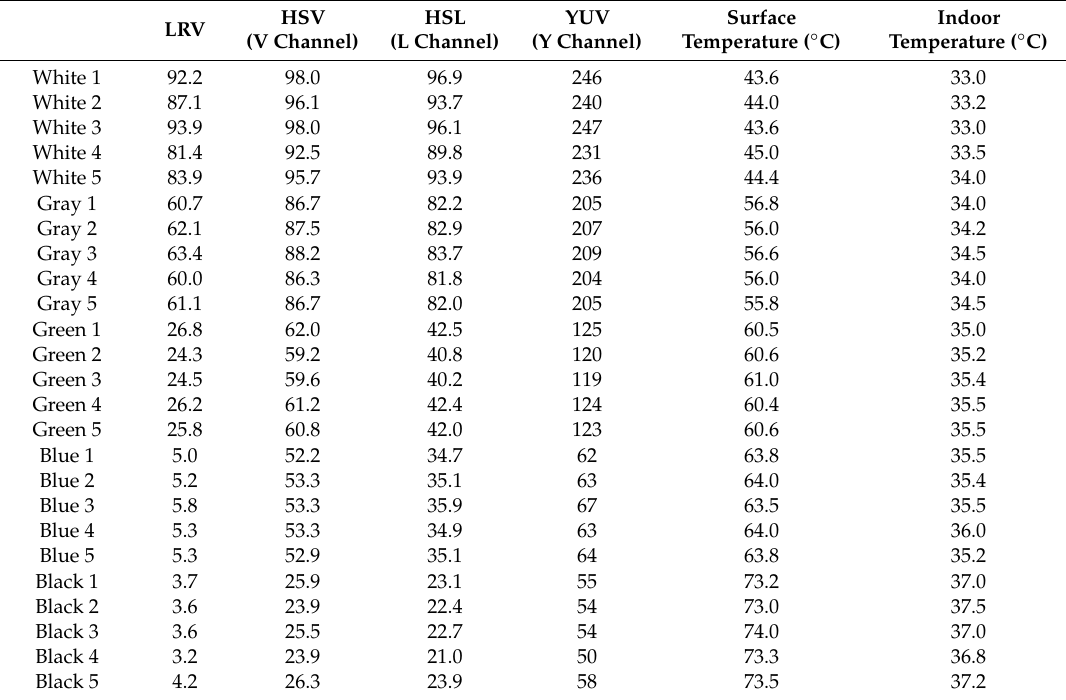
Table 4. Values for the color space technology (i.e., LRV, HSV, HSL and YUV), surface temperature, and indoor temperature according to color.